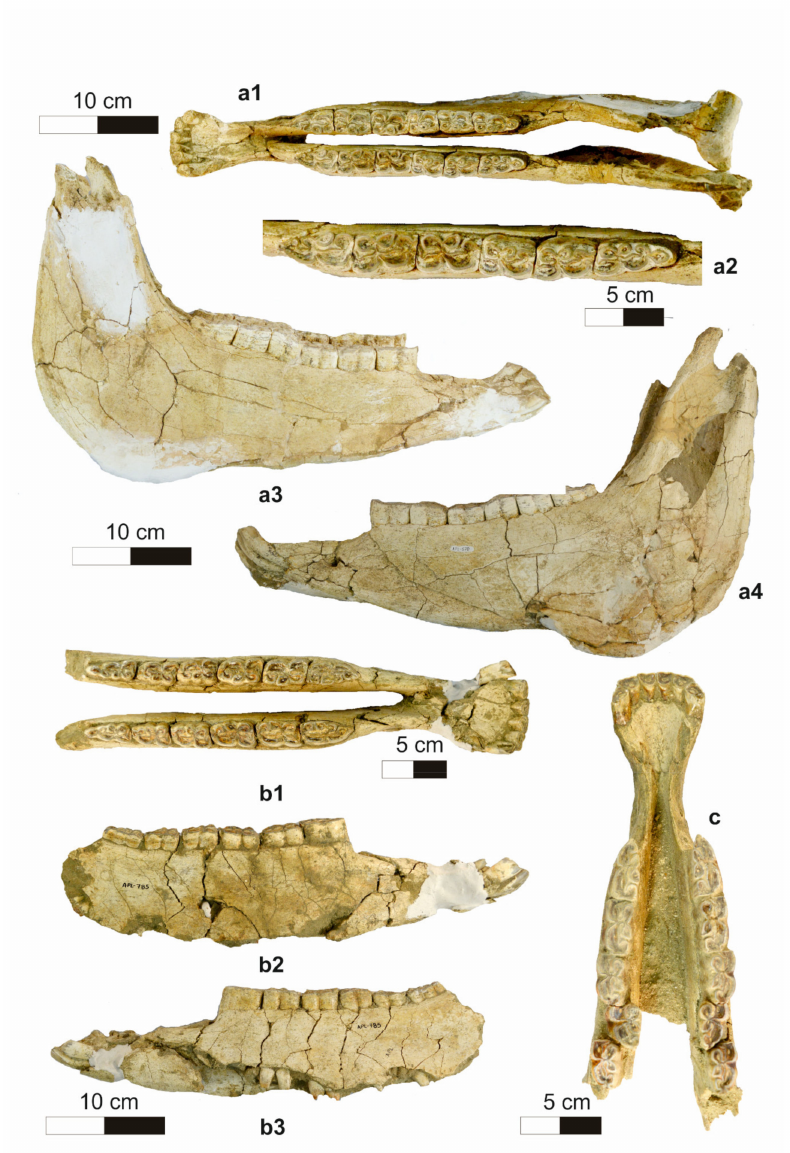
Figure 6. Equus apolloniensis , ( a1 – a4 ) mandible, APL-570, ( a1 ) occlusal view, ( a2 ) left tooth row, ( a3 ) right lateral view, ( a4 ) left lateral view; ( b1 – b3 ) partial mandible, APL-785, ( b1 ) occlusal view, ( b2 ) right lateral view, ( b3 ) left lateral view; ( c ) partial mandible, APL-792, occlusal